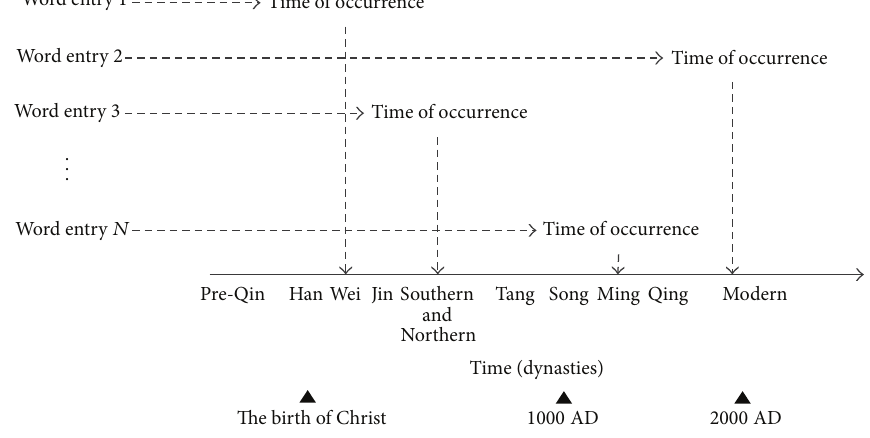
Figure 1: Determining the time of occurrence per word entry by the earliest textual evidence with CDCW